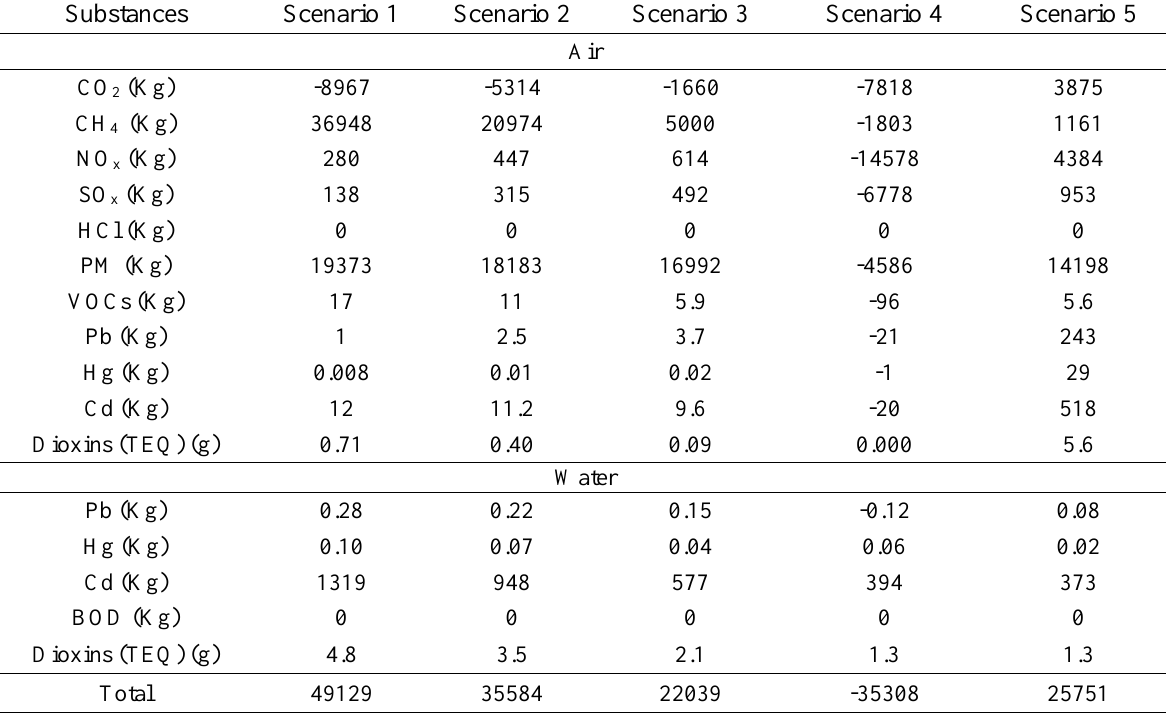
Table 4. Emissions and damages for the scenarios Substances